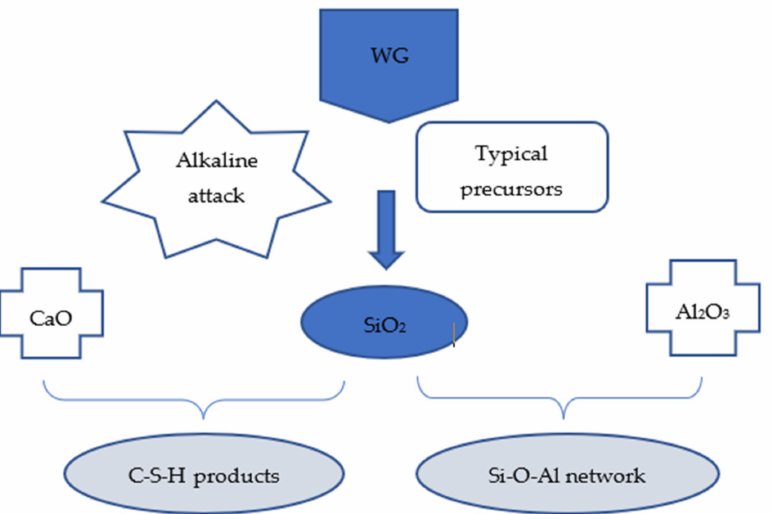
Figure 17. Different reaction product formations after alkali activation and geopolymerization of WG and other typical